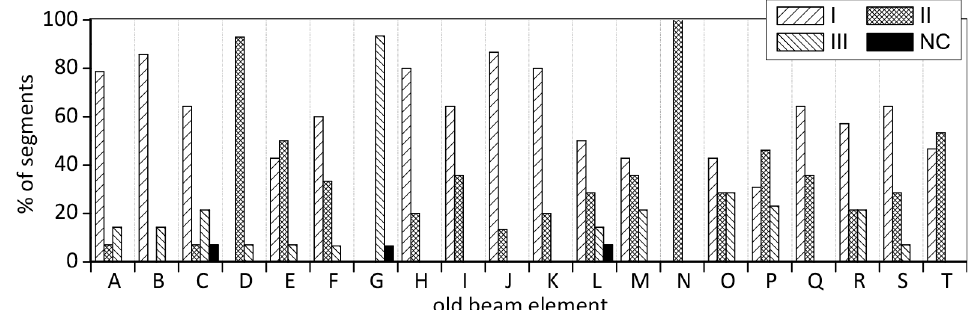
Fig. 4. Percentage distribution of segments in the old beams included in each visualgrading class (UNI 11119:2004) without considering damage due to external causes